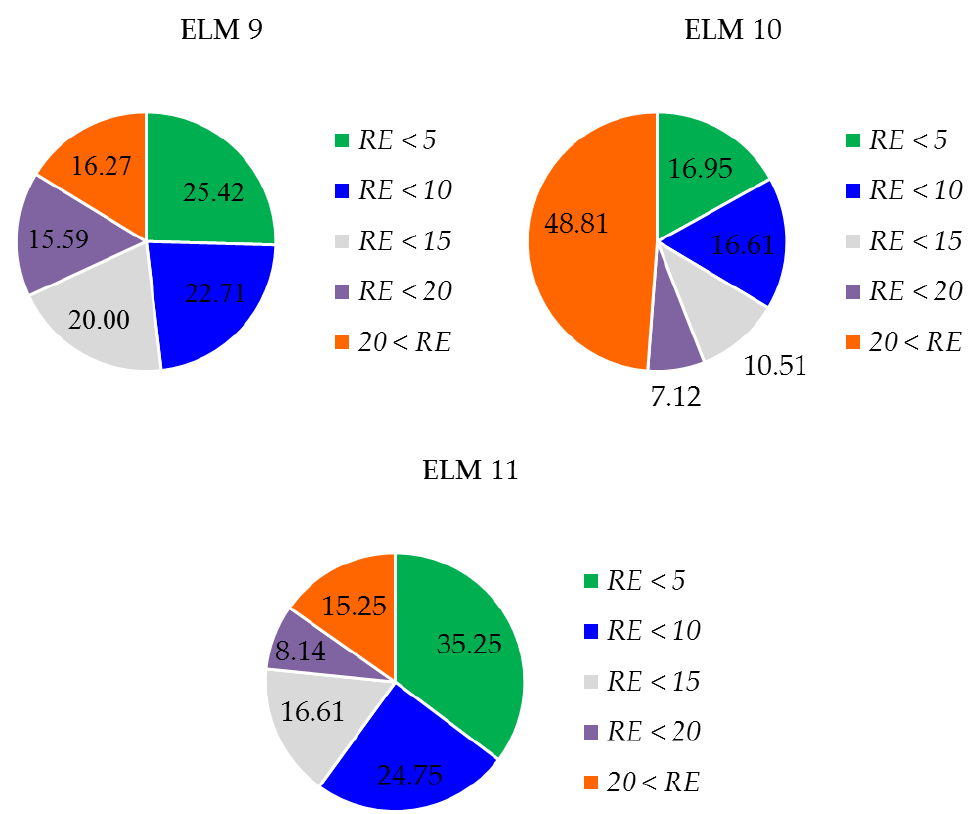
Figure 5. Relative error distribution for di ff erent input Figure 6. Relative error distribution for different input combinations.